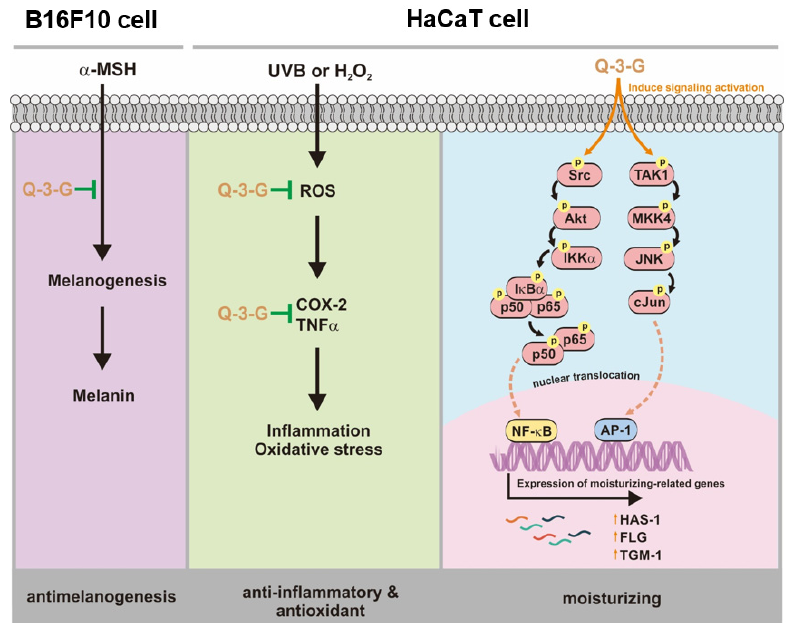
Figure 5. Anti-inflammatory, antioxidant, moisturizing, and antimelanogenesis mechanisms of Q-3-G in human keratinocytes and melanoma cells.